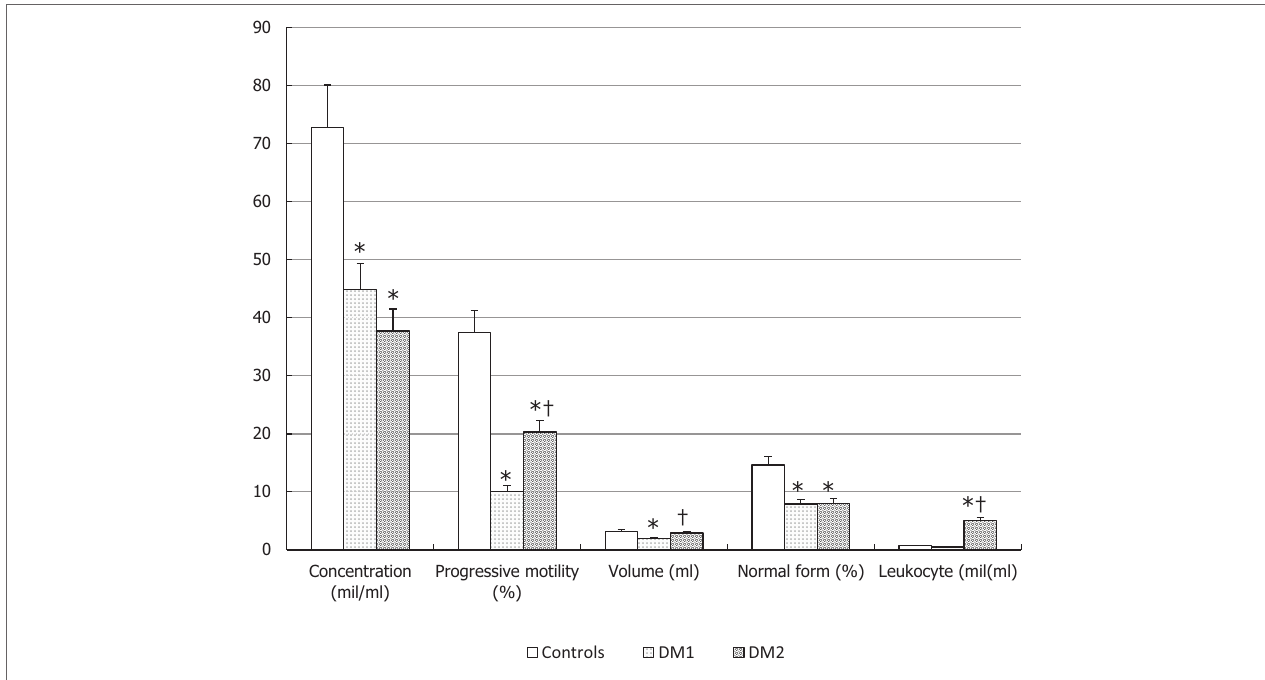
FigUre 1 | Conventional sperm parameters in patients with type 1 diabetes mellitus (DM1), type 2 diabetes mellitus (DM2), and the control (CTL) group. * p < 0.05 vs. CTL; † p < 0.05 vs. DM1. The results are expressed as mean ±